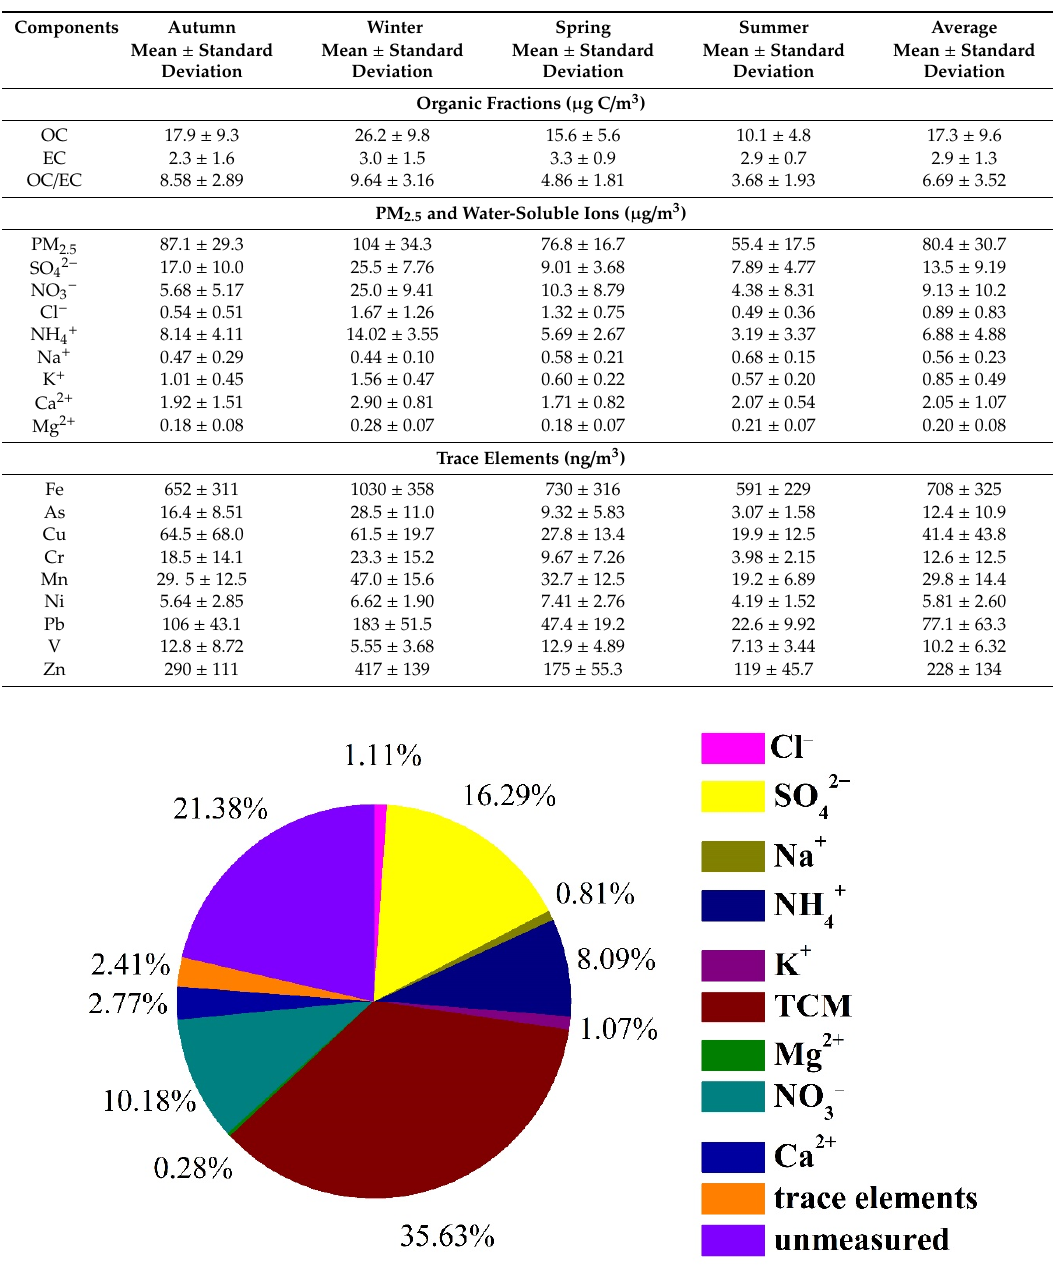
Table 1. The concentrations of chemical components in PM 2.5